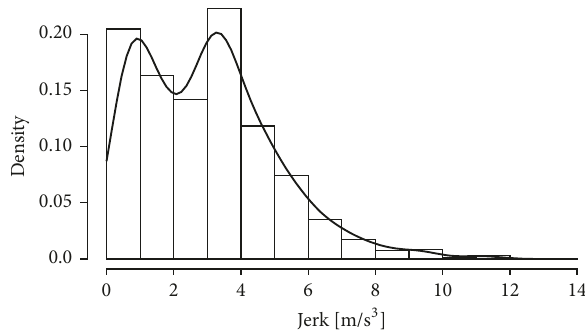
Figure 8: Density distribution of the RMS of jerk experienced for all